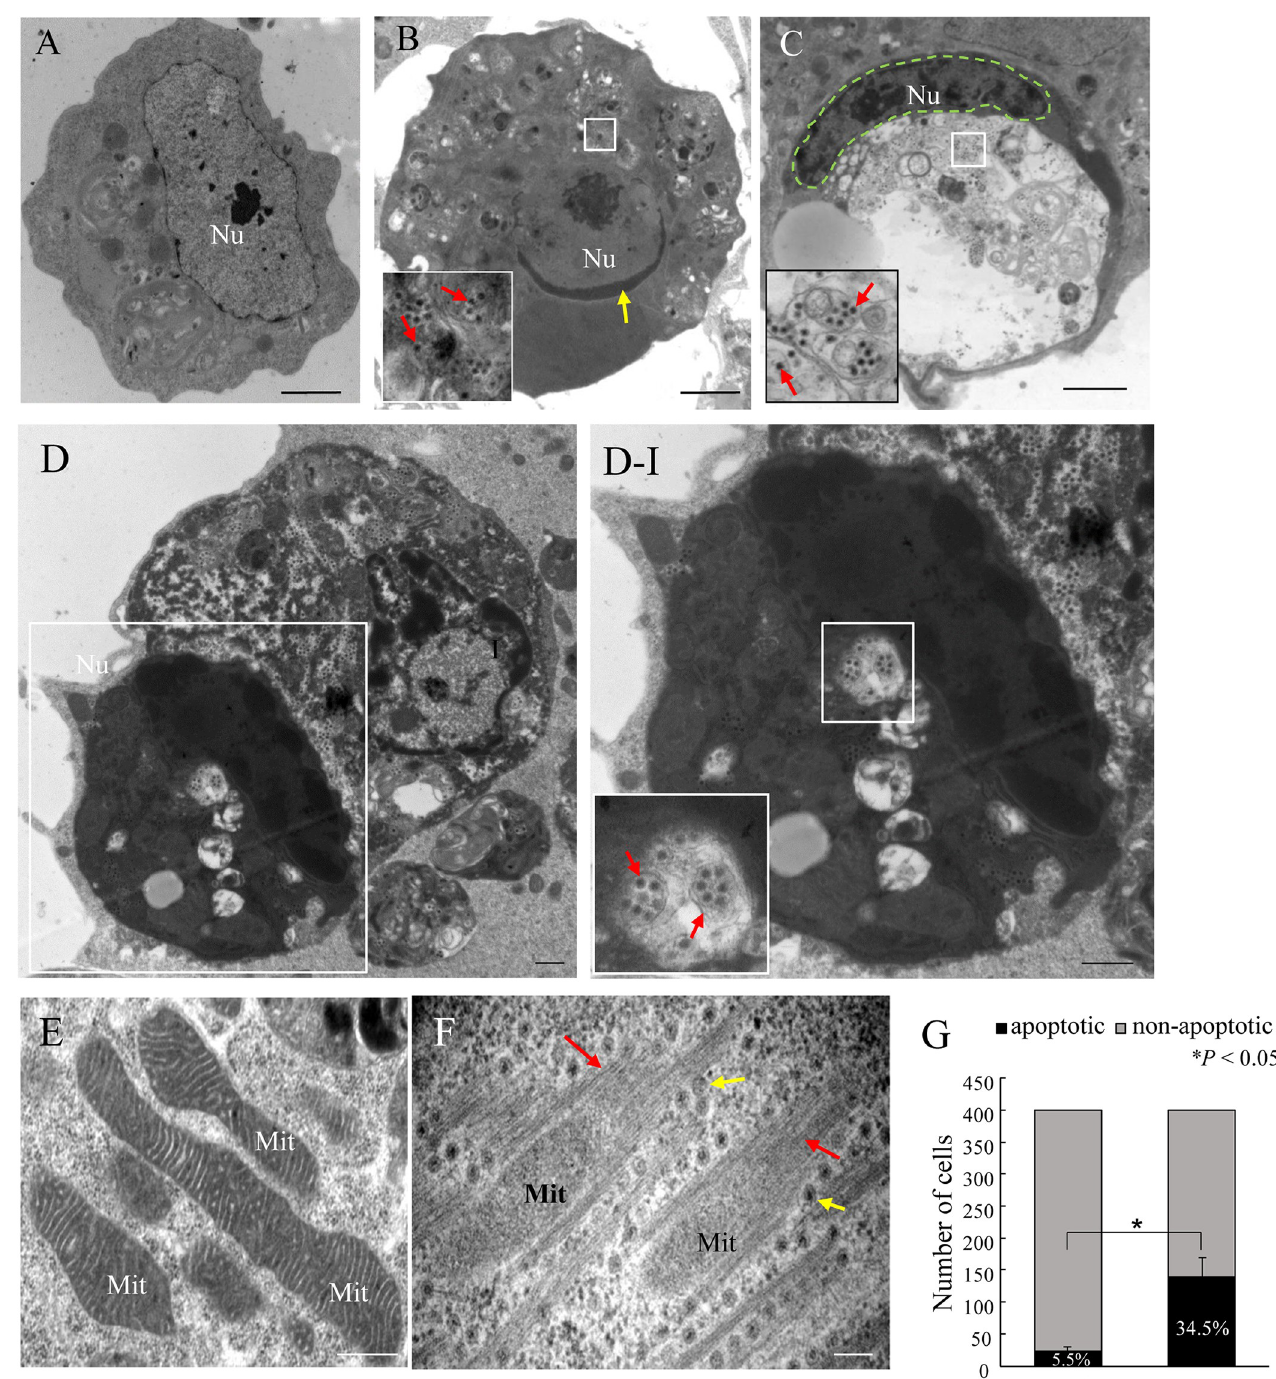
Fig 1. RGDV infection induced morphological hallmarks of apoptosis in continuous cultured cells of R . dorsalis . Cell cultures derived from R . dorsalis were originally established from the embryonic fragments dissected from eggs and subcultured for more than 100 generations. Cultured cells were inoculated with purified RGDV (MOI of 1) and processed at 48 hpi for TEM. The infection rate at this time was approximately 70%. (A) Mock-infected cultured cells of R . dorsalis with normal cellular morphology. (B) Condensed chromatin in cells infected by RGDV particles (red arrows) was marginalized along the nuclear inner envelope and appeared as cup-shaped masses (yellow arrow). (C) The nucleus (green dotted line) in cells infected by RGDV particles (red arrows) was crescent- shaped. (D) Large cell engulfing an apoptotic body containing RGDV particles (red arrows). (E) Intact mitochondria with distinct, tightly involute cristae in mock-infected cells. (F) Degenerated mitochondria with indistinct, diffuse cristae surrounded by fibrillar structures (red arrows) in virus-infected cultured cells of R . dorsalis . Yellow arrows indicate RGDV particles along the edges of fibrillar structures. Inserts in panels B, C and D-I are enlargements of the respective